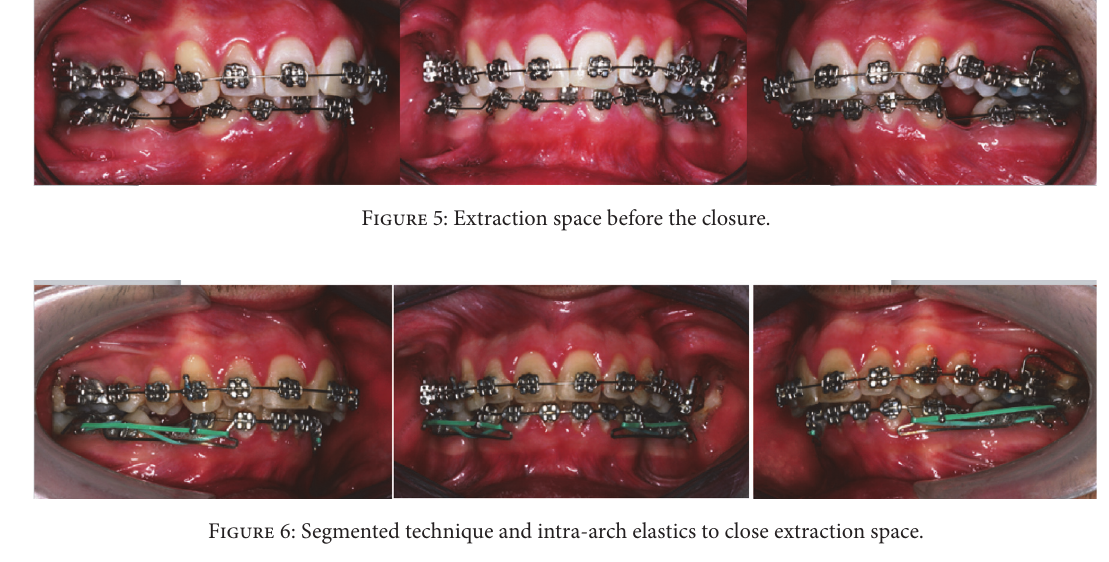
Elgiloy (cid:2) and 0.016 ∗ 0.022 -inch Elgiloy, also for